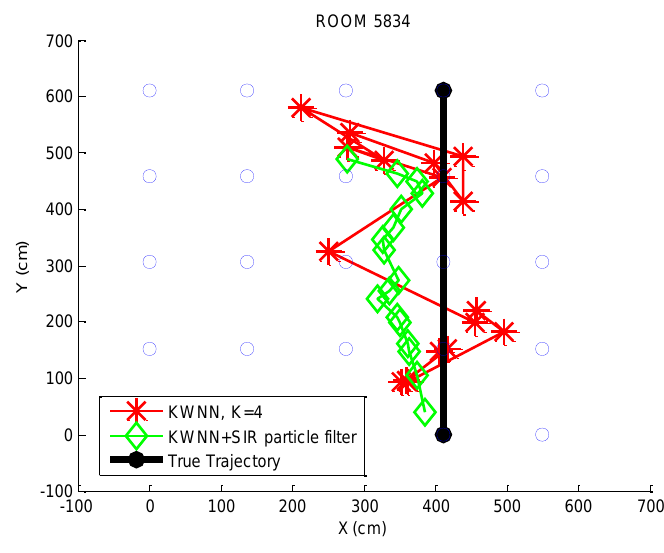
Figure 13. The dynamic positioning results by the KWNN algorithm ( K = 4).